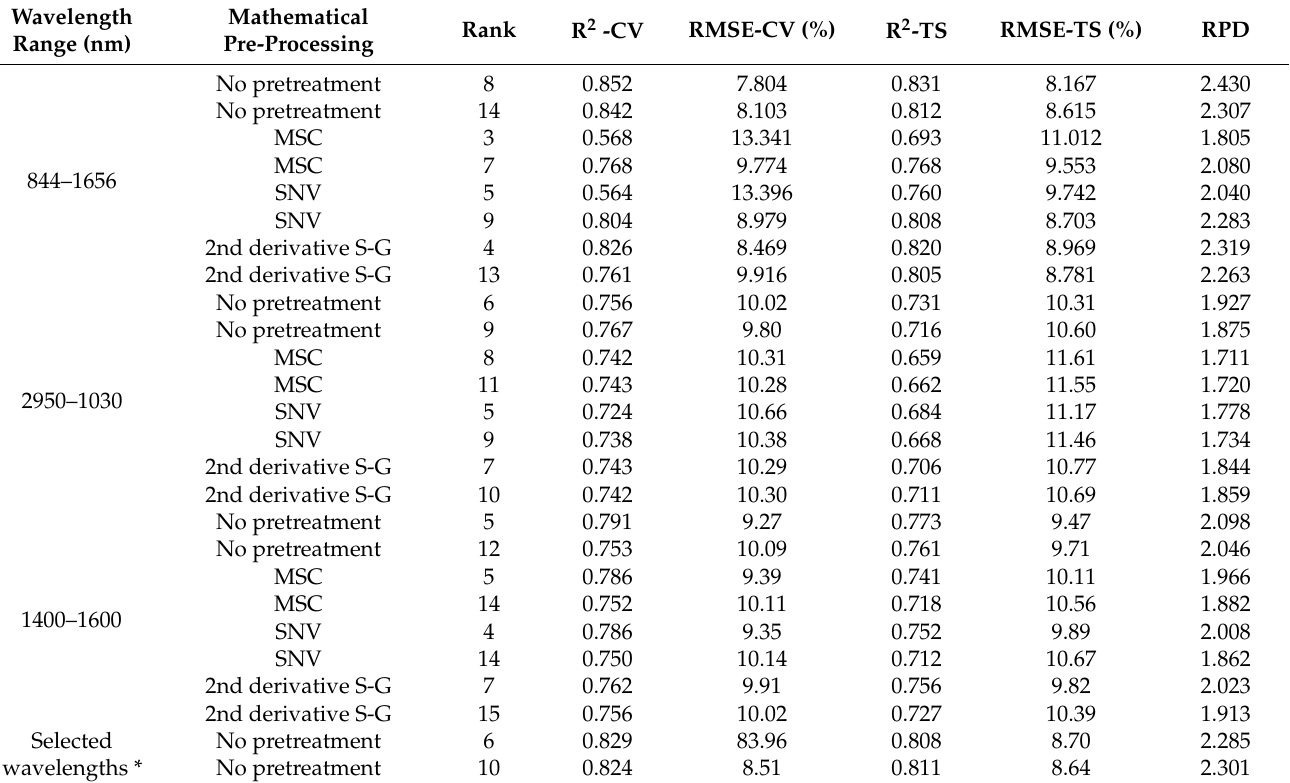
Table 2. The summary statistics for the best predictive models (tested wood plane: radial).